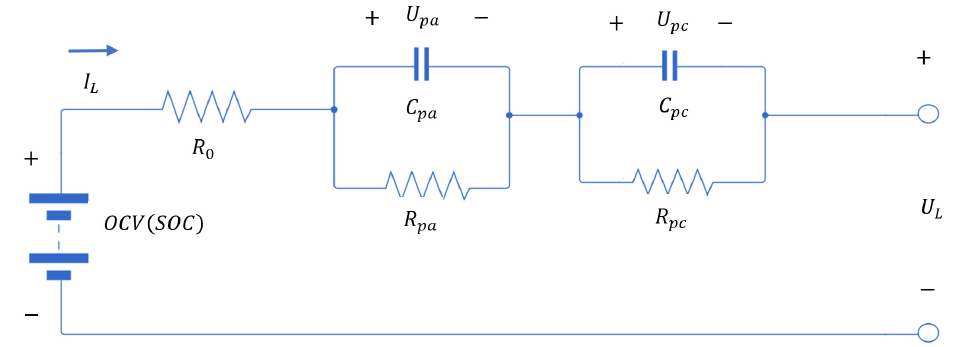
Figure 1. Dual polarity model schematic [18].